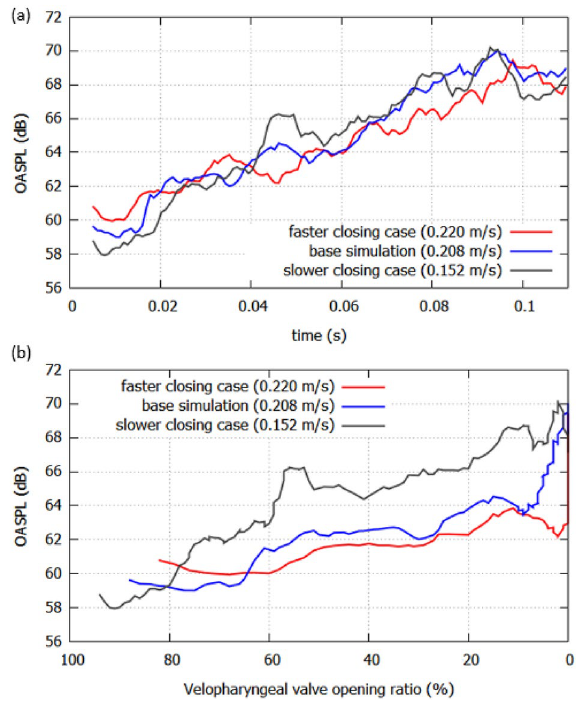
Figure 7. ( a ) The OASPLs with the different closing speed. ( b ) The OASPLs based on the velopharyngeal valve opening ratio.